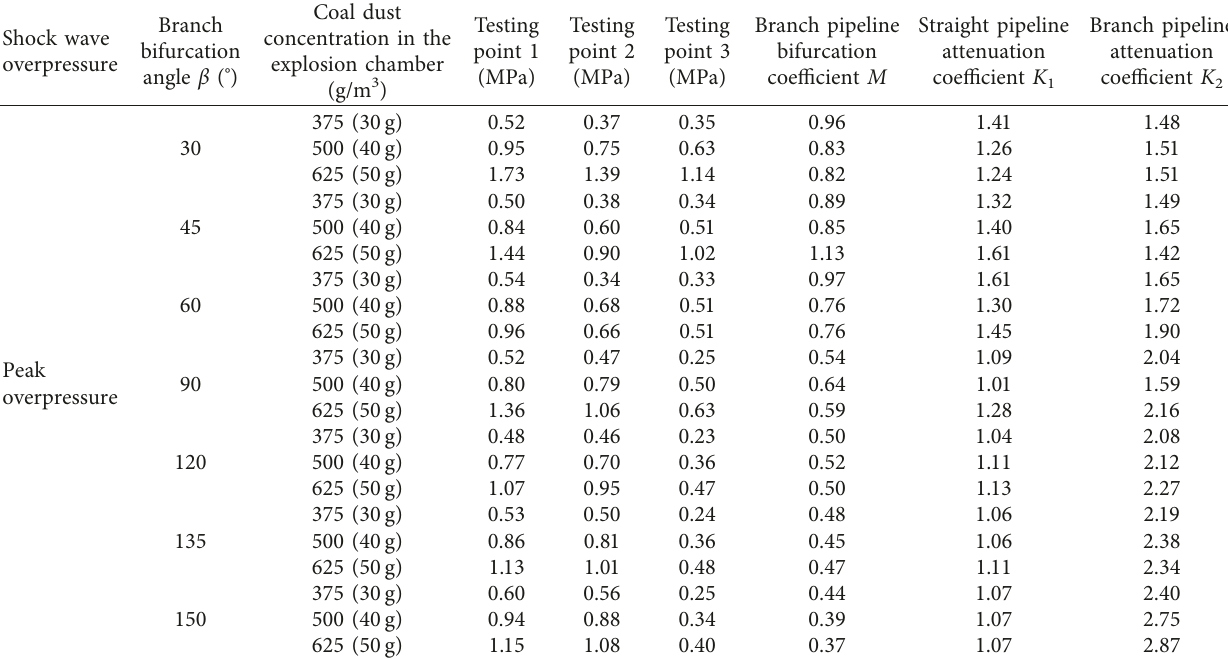
Table 2: Coefficient shunt and attenuation coefficient of the gas and smut explosion shock wave via the one-way bifurcation pipeline. Shock wave